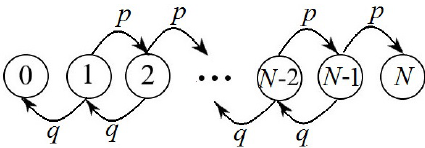
Figure 6. Graph, describing player’s ruin